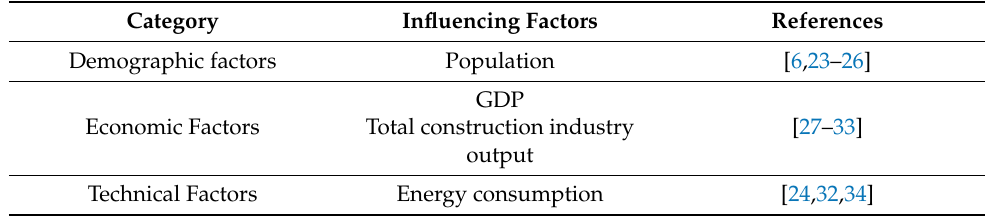
Table 3. Selection of influencing factors.